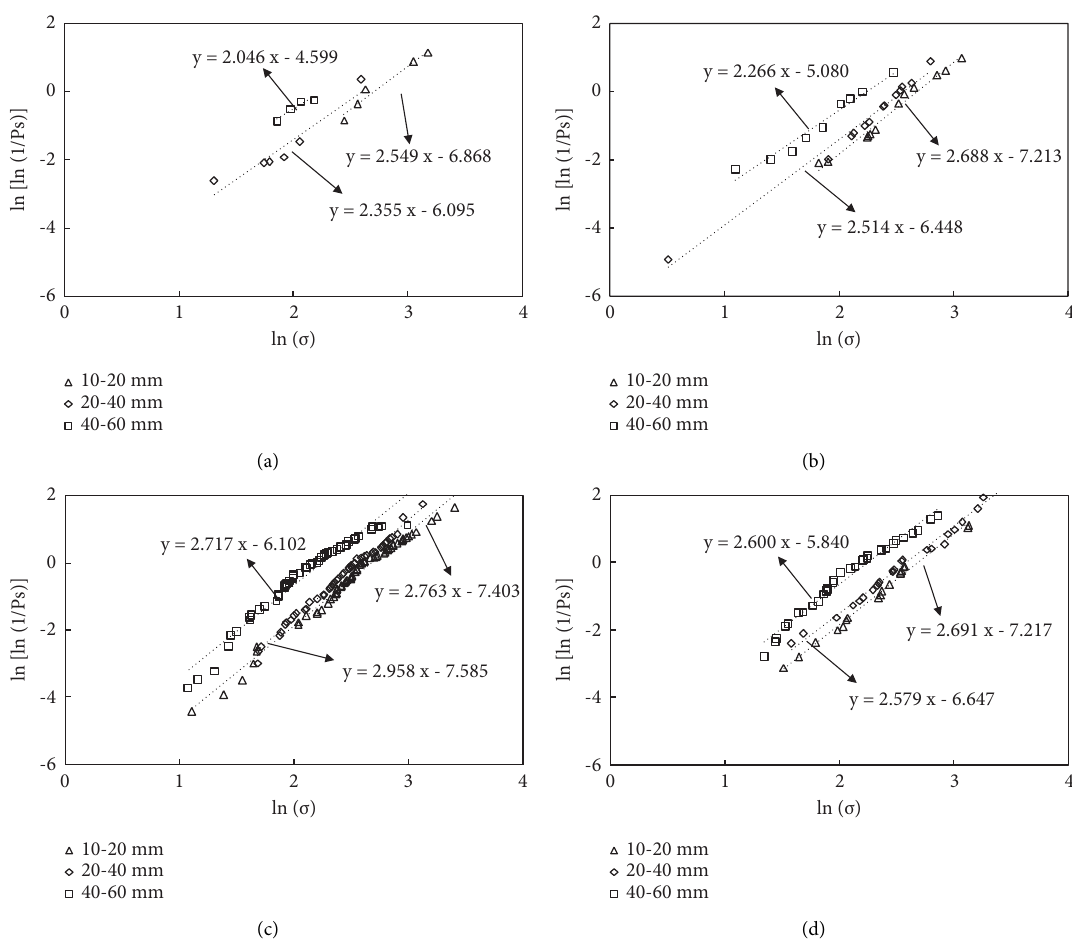
Figure 11: Weibull distribution diagram of crushing strength of four types of particles: (a) foliated particles, (b) elongated particles, (c) subspherical particles, and (d) fat particles. Table 5: Weibull parameter of crushing strength of particles with four diferent shapes. Grain size